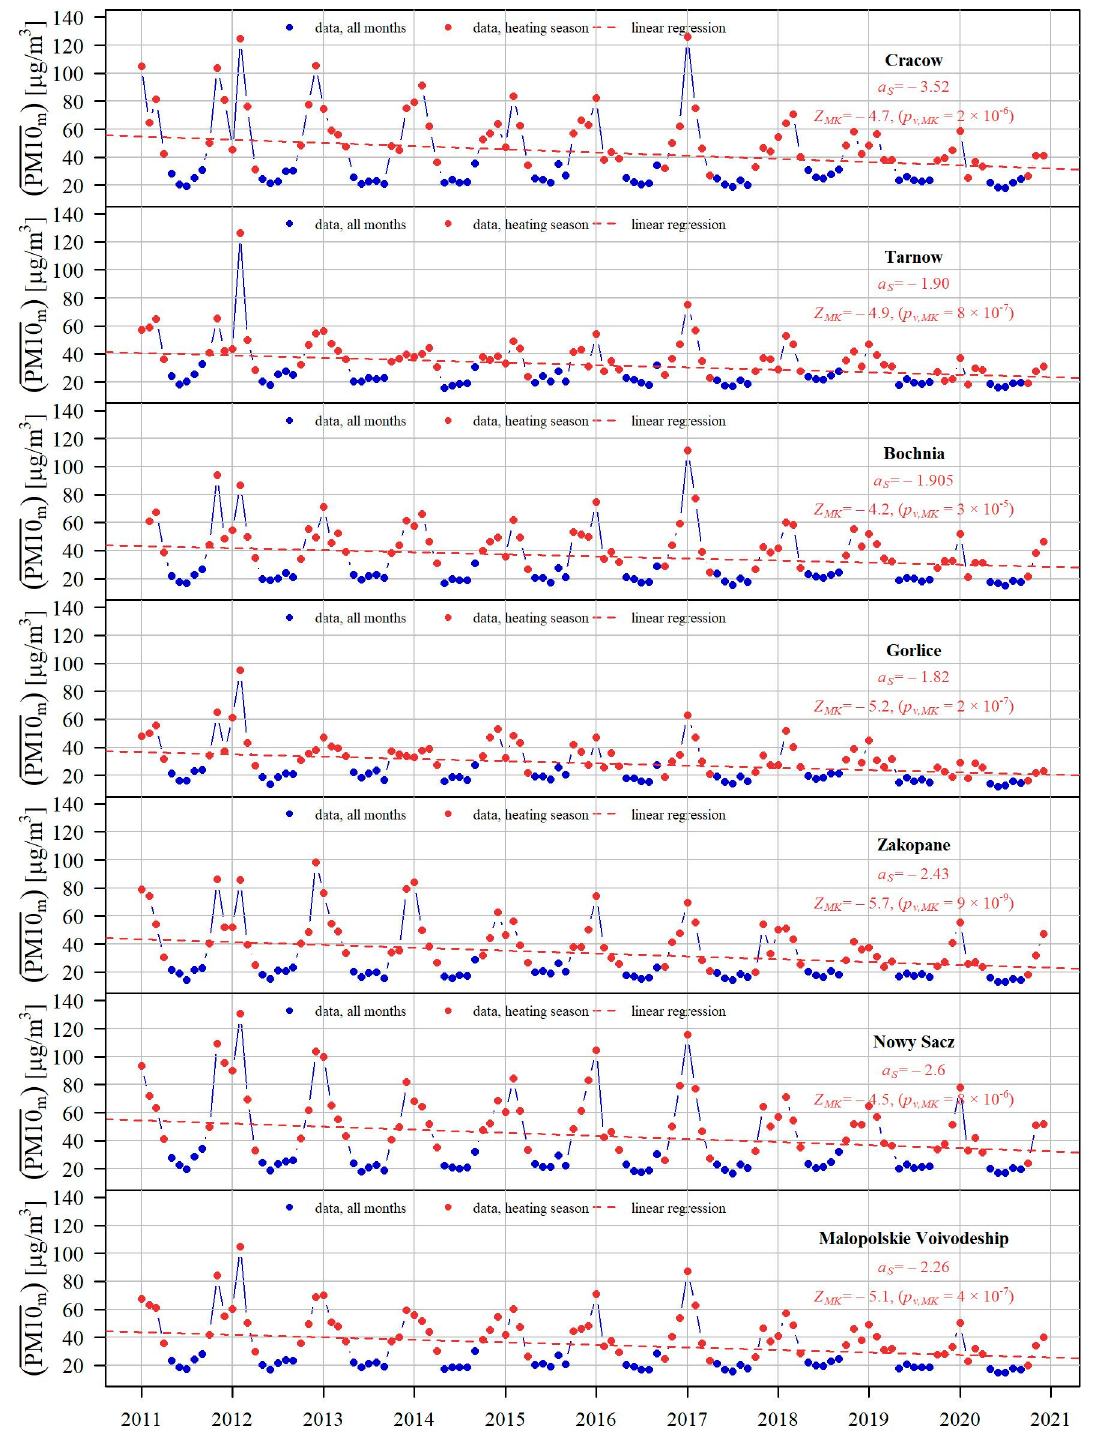
Figure 8. Distributions of average monthly concentrations of PM10 m in 2011–2020: for all months (blue points) and the heating season (red points). The symbol a TS means seasonality Sen’s slope [ng/m 3 /year], while Z MK and p v , MK are the result of the seasonal Mann–Kendall test. Linear regressions (dotted lines) are shown for comparison. (Source: own elaboration based on the data from the database of the Chief Inspectorate for Environmental Protection [29]).